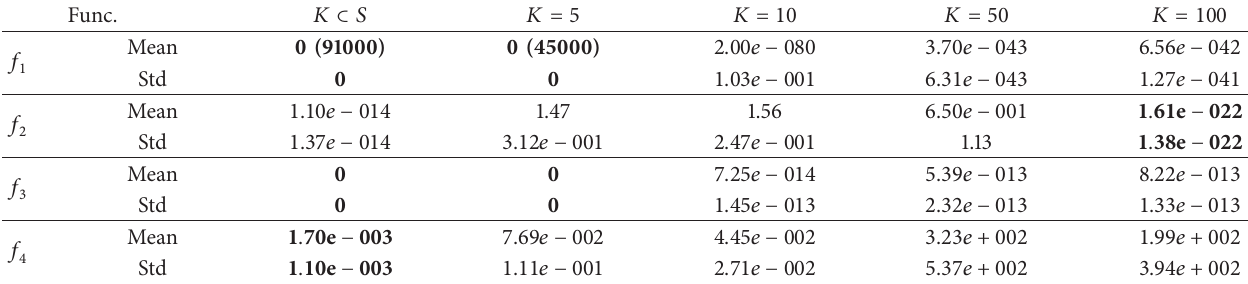
Table 3: Performance of HABC on 100 𝐷 benchmark functions 𝑓 1 – 𝑓 4 with the different grouping number 𝐾 . In bold are the best results. Note that values indicated in brackets denoted to function evaluations (FEs) are used to obtain the optimal value.